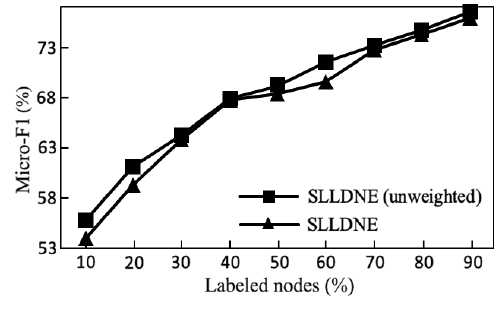
Fig. 3 Performance w.r.t. the number of embedding dimensions on CiteSeer.